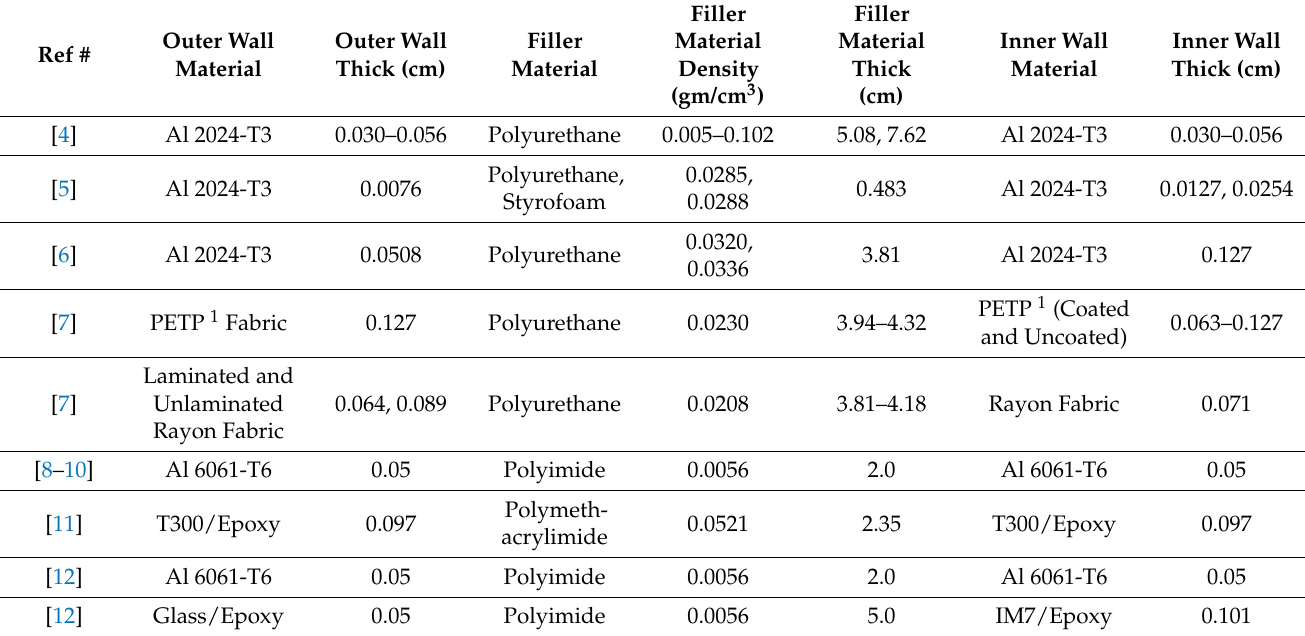
Table 2. Target Configurations and Materials Used in Previous Experimental Programs and Numerical